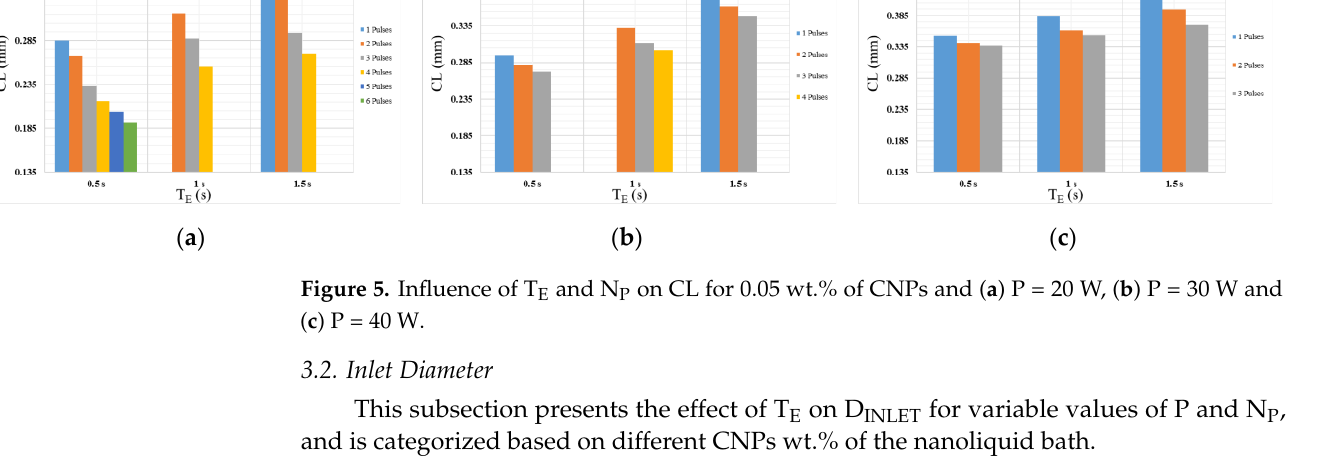
Figure 5. Influence of T E and N P on CL for 0.05 wt.% of CNPs and ( a ) P = 20 W, ( b ) P = 30 W and ( c ) P = 40 W.